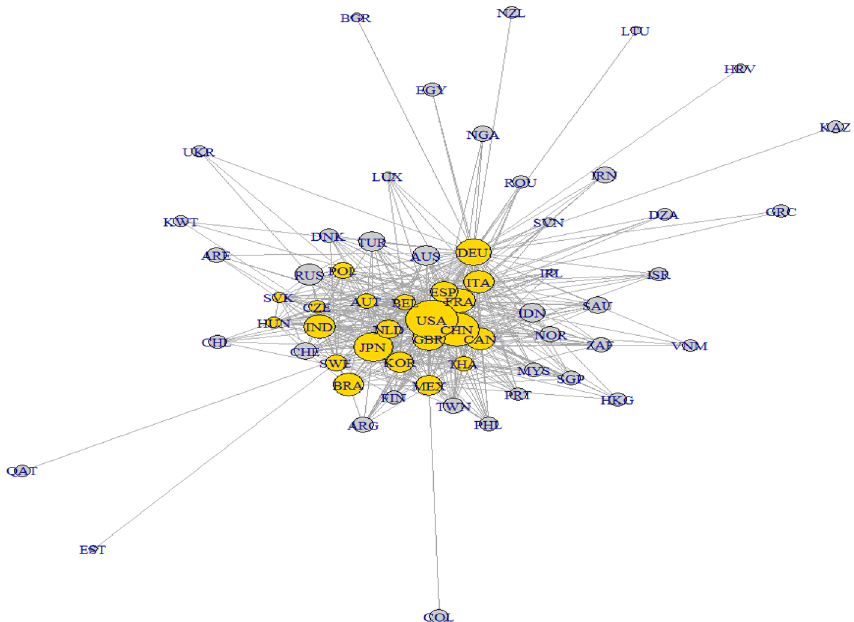
Fig. 4 Largest clique. Color represents the countries that are inside the largest clique. The Fruchterman– Reingold layout was used to produce this graph (Source: Own elaboration with EORA